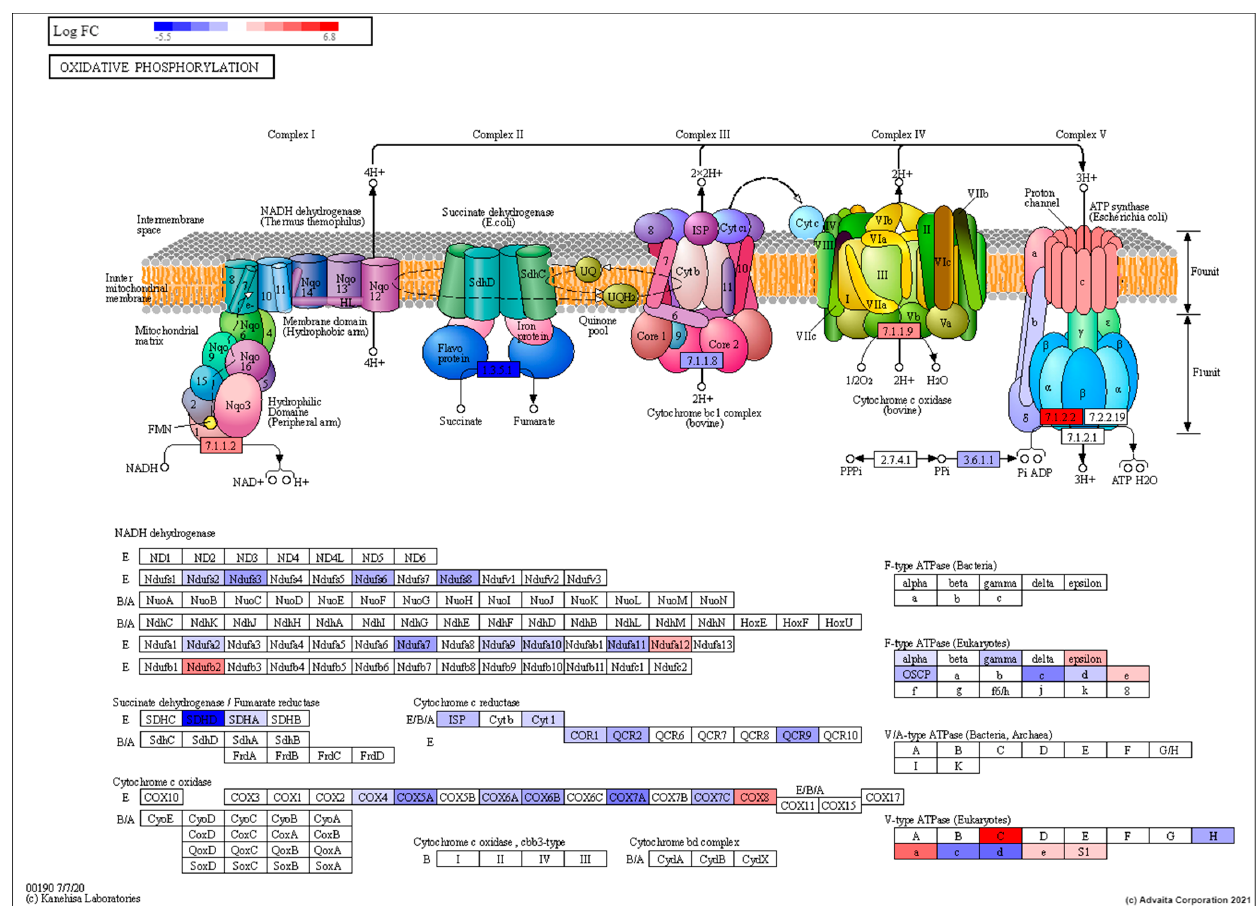
Figure 4. Pathway topological diagram of the oxidative phosphorylation pathway produced by KEGG showing differentially expressed genes from a comparison between the torpor and control group showing the torpor group experienced an overall downregulation of several key subunits of electron transport chain proteins such as NADH dehydrogenase, succinate dehydrogenase and cytochrome c oxidase, indicating reduced energy production. RED: upregulated, BLUE: downregulated.